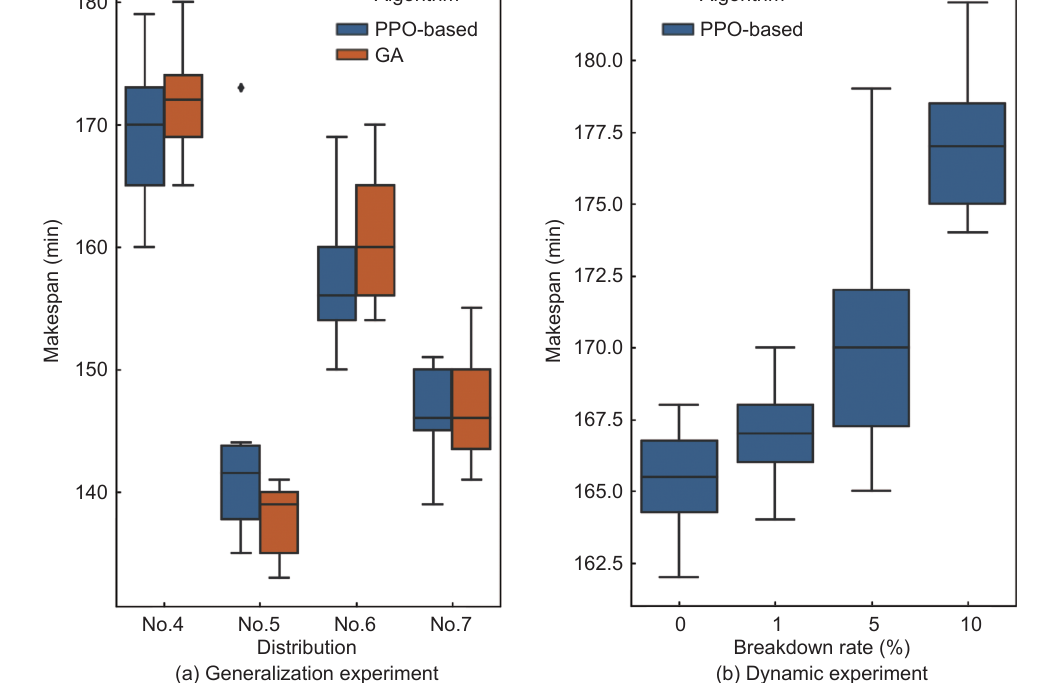
Fig. 7 Generalization and dynamic